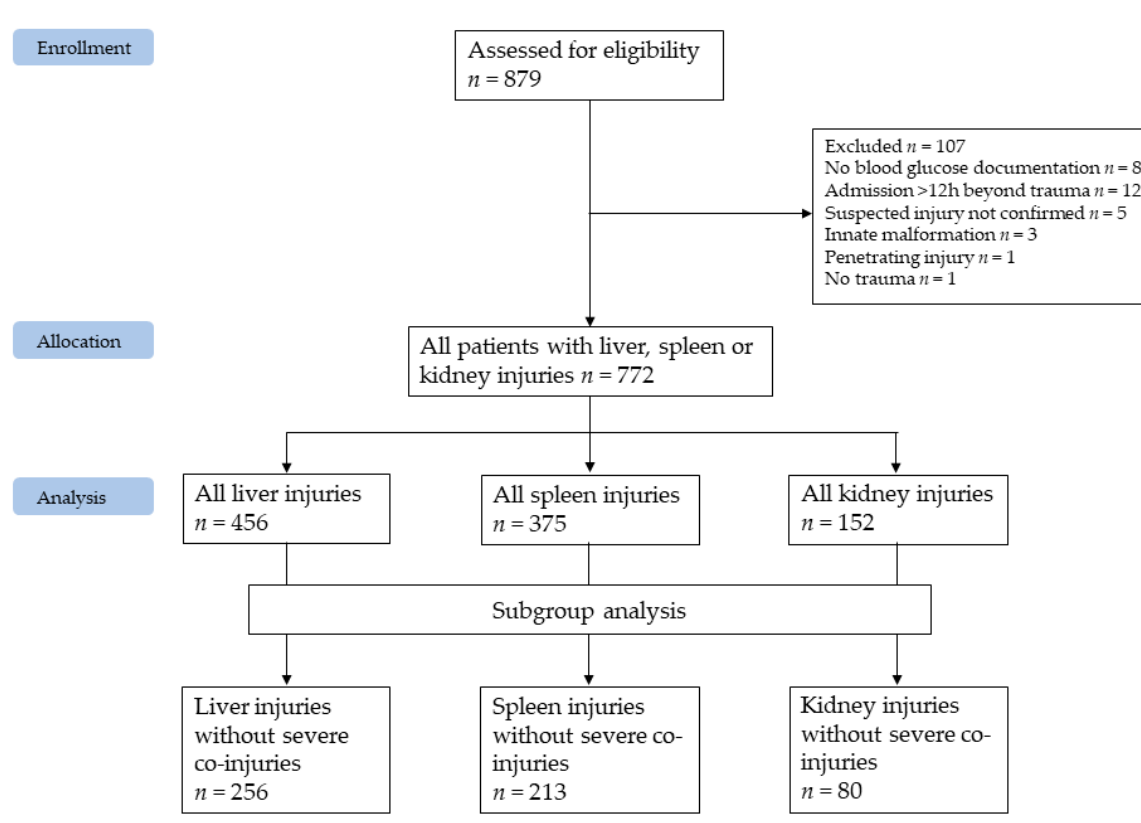
Figure 1. CONSORT flow diagram of patient population.